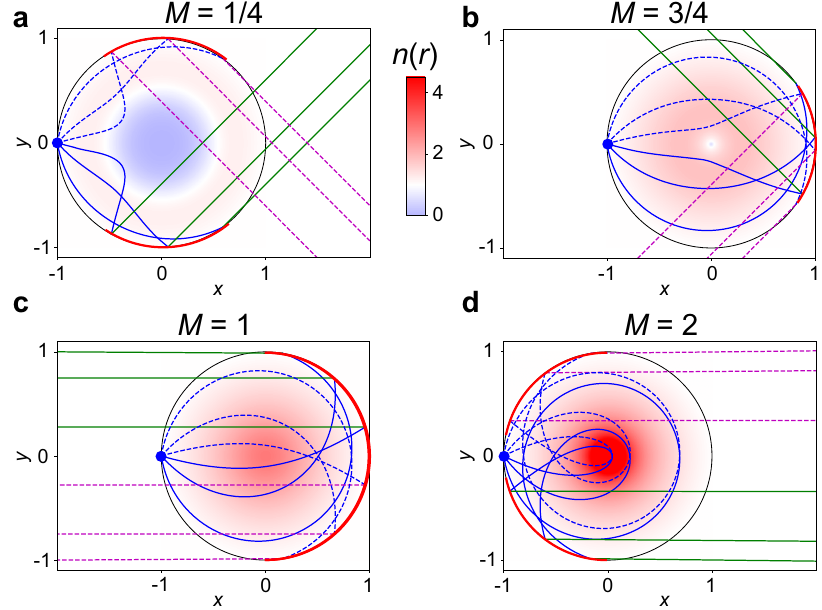
Fig. 3 Double-layer lenses with one focus at r = 1. From an initial point source at r s = 1, ϕ = π (blue dot) we trace the ray motion through the pro fi les de fi ned through the implicit Eq. (30) for different values of M . To aid visualization we plot the rays launched in the + y direction as dashed lines, and those launched in the − y direction as solid lines. We give four examples, where the turning angle Δ ϕ is π plus a π /4; b 3 π /4; c π ; and d 2 π . When M is integer, the double-layer lens has the functionality of a ordinary (for even numbers) and double-layer (for odd numbers) Luneburg lens, otherwise, it acts as a beam splitter fed by a point